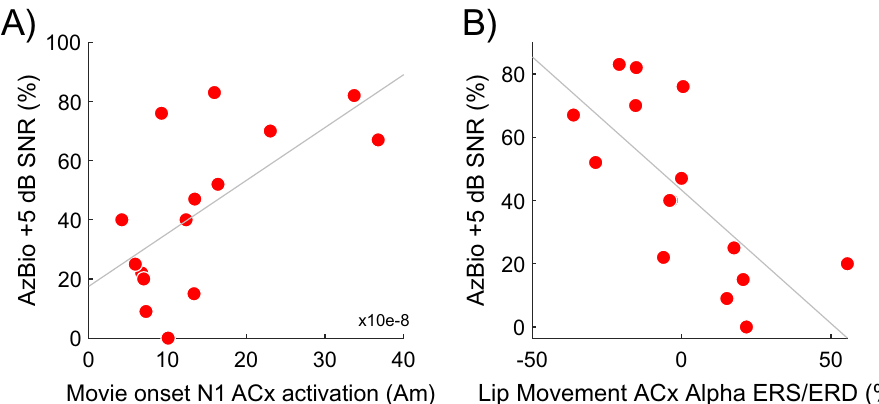
Figure 4. Correlations of crossmodal activity and speech scores. ( A ) Visual crossmodal activation of auditory cortex to the movie onset positively predicts speech-in-noise performance in CI users measured by AzBio sentences in speech-shaped background noise at + 5 dB SNR. ( B ) Alpha synchronization and desynchronization during speech-related lip movement expressed as a percent change in 8 to 12 Hz power from baseline negatively predicts speech-in-noise